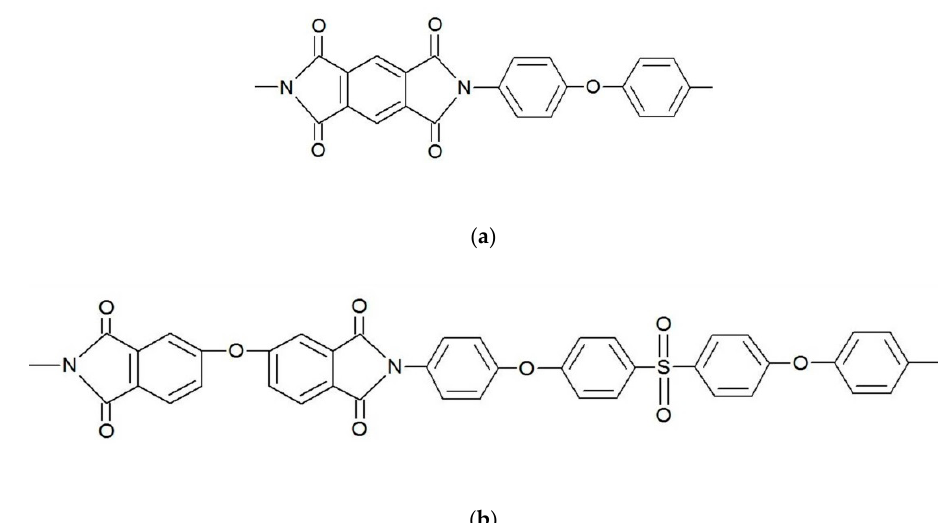
Figure 1. Structural formulas of elementary units of the polyimides (PIs ) used in the present investigation. ( a ) PMDA-ODA (PI with a repeating unit based on pyromellitic dianhydride (PMDA) and oxydianiline (ODA)) ; ( b ) DPhO-BAPS (PI with a repeating unit based on 2,3,3’,4’-diphenyl ether tetracarboxylic acid dianhydride (dianhydride DPhO) and 4,4 ′ -bis(4 ″ -aminophenoxy)biphenyl sulfone (diamine BAPS)).